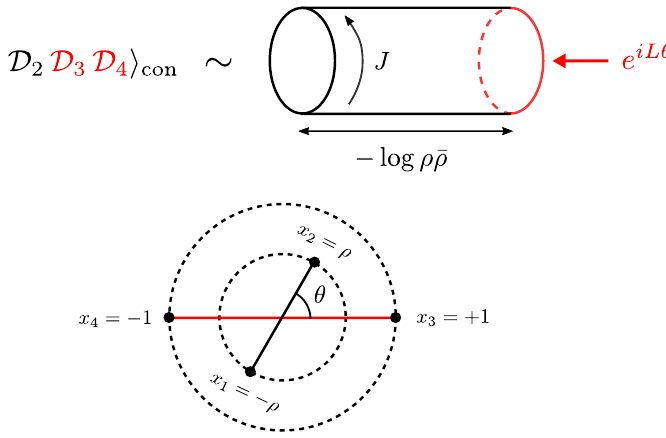
Figure 35 . The cylinder partition function and the (cid:26) -coordinate. The connected four-point func- tion of determinant operators is given by the (exponentiated) cylinder partition function. The length of the cylinder is related to the absolute value of the (cid:26) coordinate, which is de(cid:12)ned in the lower (cid:12)gure. The angle of the (cid:26) coordinate is related to the twist of the boundary condition e iL(cid:18) , where is the L is the spacetime